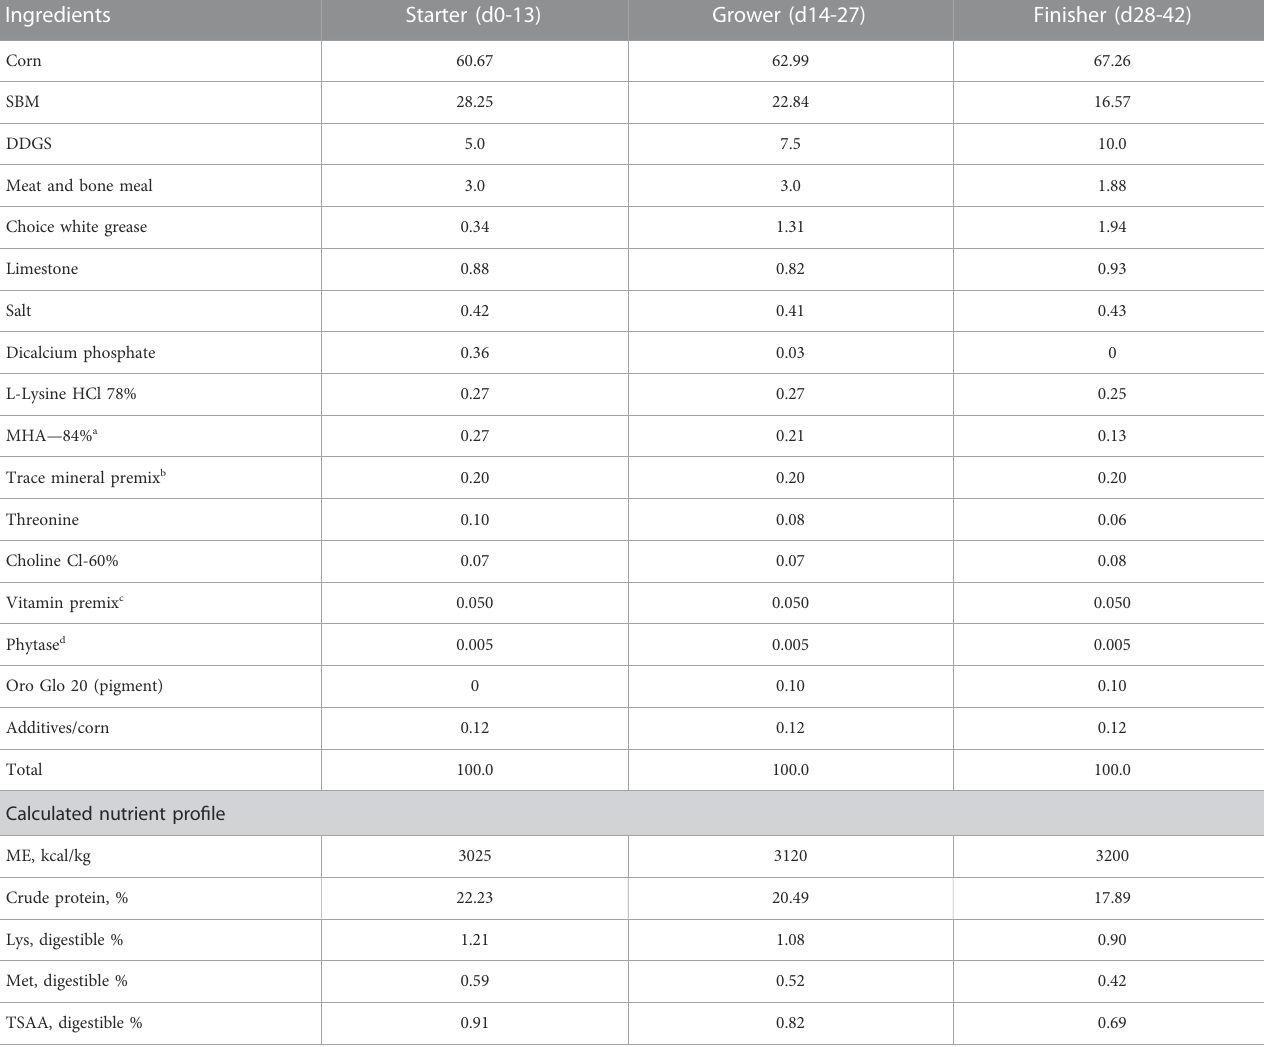
nine replicate pens of 13 broilers with randomized complete block design. Broilers were vaccinated with 1× recommended dose of coccidiosis vaccine (mixed species of E. acervulina , E. tenella , and E. maxima from Huvepharma, Inc.) by oral gavage on d0. On d41, 1 bird/pen was sacri fi ced to collect duodenum and jejunum tissue for gut morphometry measurement and cecal content for bacteria quantitation.